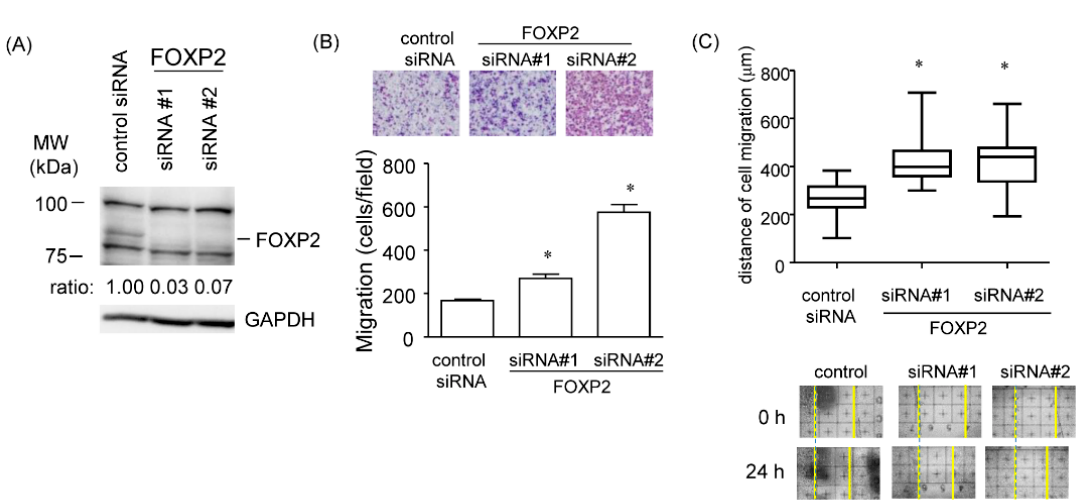
Figure 8. Promotion of cell migration in FOXP2 knockdown cells. ( A ) Amounts of FOXP2 protein in non-MG cells treated with two siRNAs targeted to distinct FOXP2 sequences were measured using western blotting with GAPDH as a loading control. ( B ) Upper panels show representative images of Diff-Quick staining in four experiments of transwell migration assays, and a lower graph shows quantification of cell migration expressed by cell counting. Data are expressed as the mean ± standard deviation (SD; n = 4). * Statistically significant difference versus control (unpaired Student’s t -test, p < 0.05). ( C ) Scratch assay was performed in non-MG cells with FOXP2-siRNA treatment. Migration distance was measured 24 h after cells were scratched. Representative images were shown in lower panels. Data are expressed as the mean ± standard deviation (SD; n = 4). * Statistically significant difference versus control (unpaired Student’s t -test, p < 0.05). MW, molecular weight.